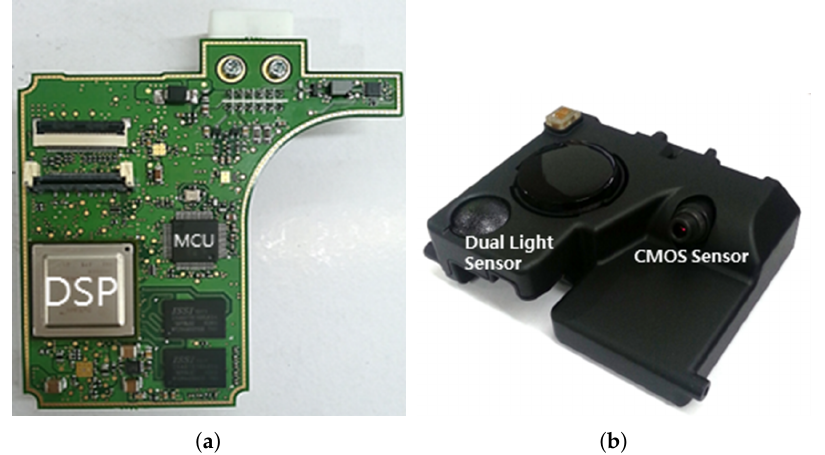
Figure 16. Photograph of realized integrated front camera module with dual light sensor: ( a ) designed circuit board and ( b ) appearance.